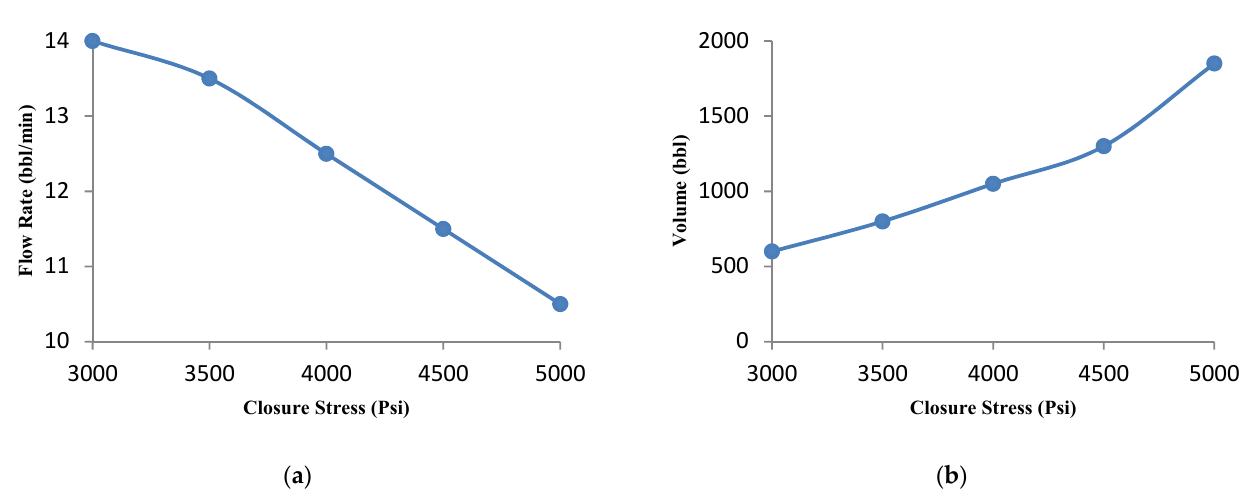
Figure 21. The influence of formation closure stress on the flow rate ( a ) and acid volume ( b ) for a 540 bbl acid volume.